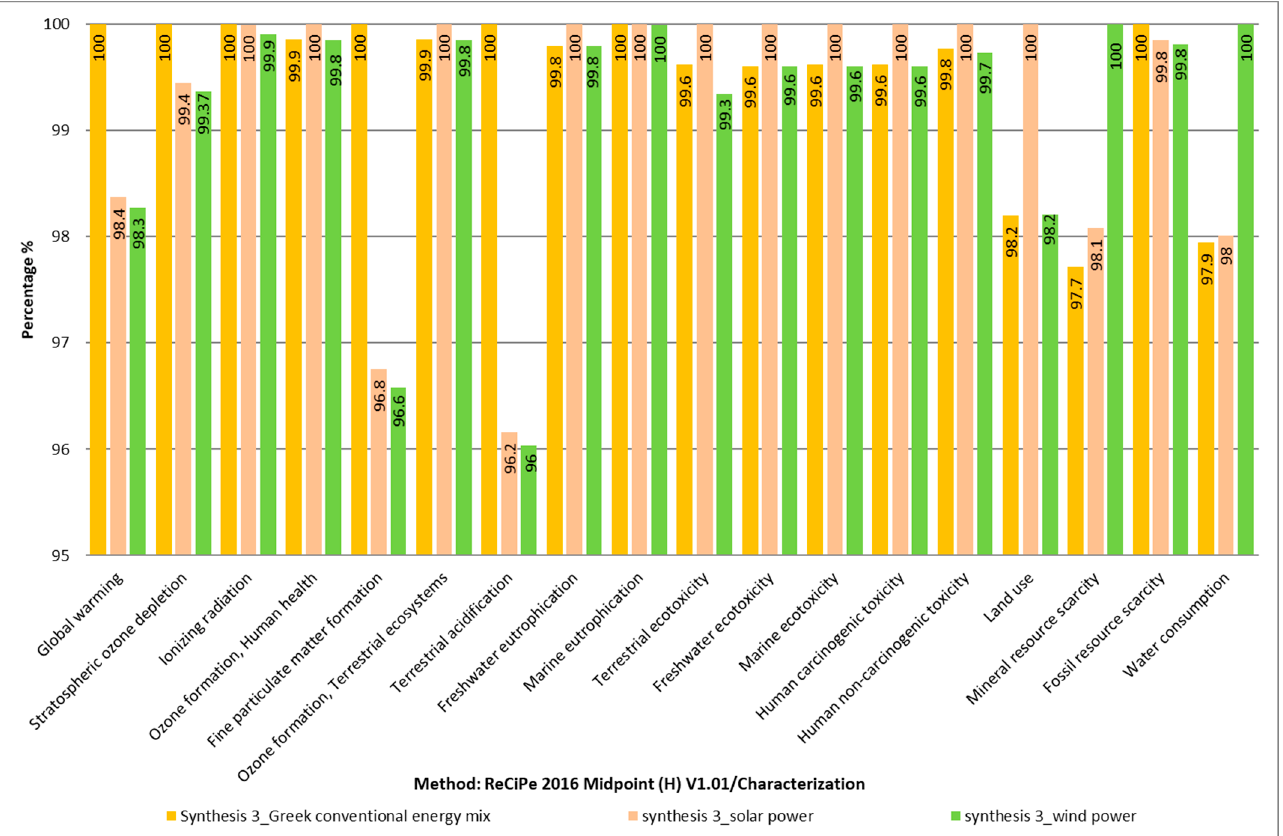
Figure 9. Comparison of Synthesis 3 impact to the environment based on various energy sources.